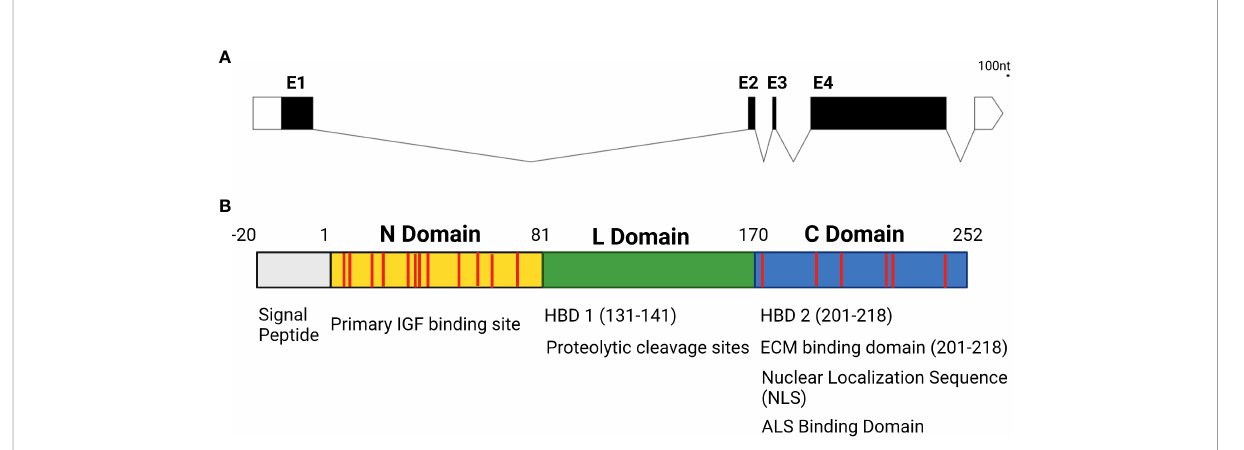
FIGURE 2 (A) Genetic structure of IGFBP5 with untranslated regions denoted in white, exons in black (E1-4) and introns displayed as lines connecting exons. (B) Protein structure of IGFBP5 with cysteine residues displayed in